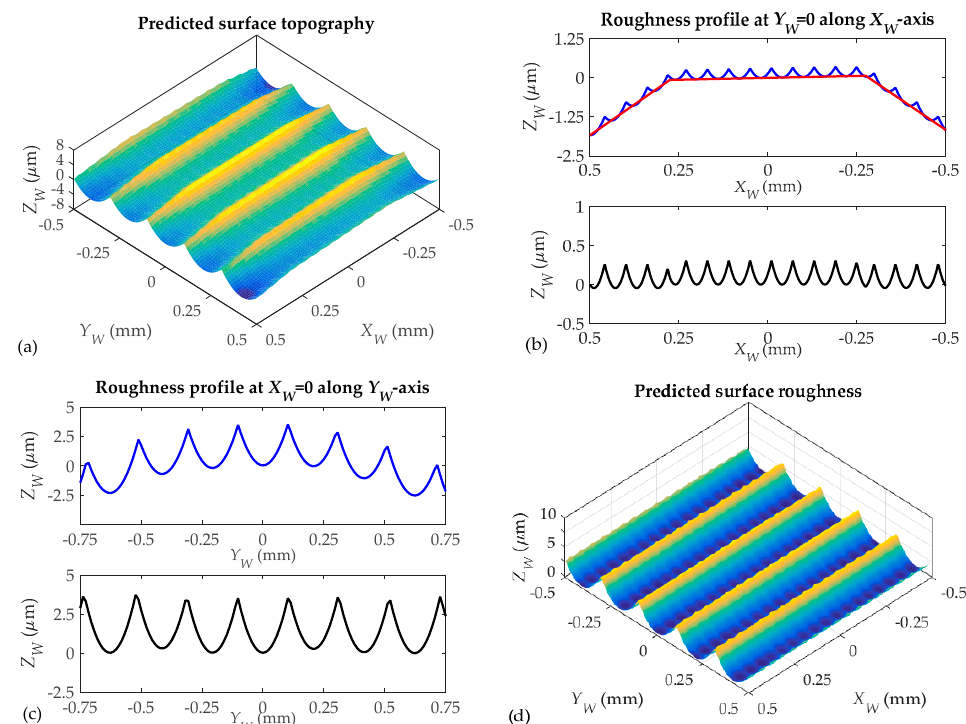
Figure 11. 3D simulated surface topography ( a ), roughness profiles ( b , c ) and surface roughness ( d ): ball end mill with 3 mm diameter and N t = 3 cutting edges and feed value f = 0.18 mm/rev.